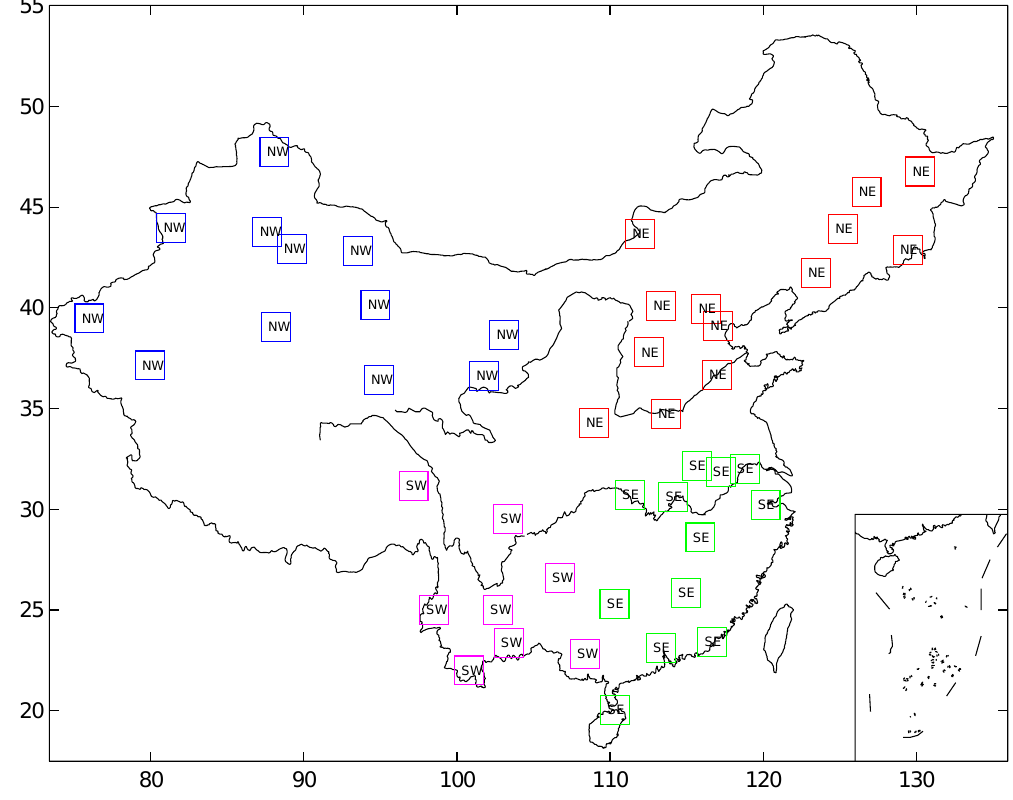
Fig. 1. Locations of pyranometer stations in China in are classified into four sub-regions, i.e., Northwest (NW), Northeast (NE), Southeast (SE) and Southwest